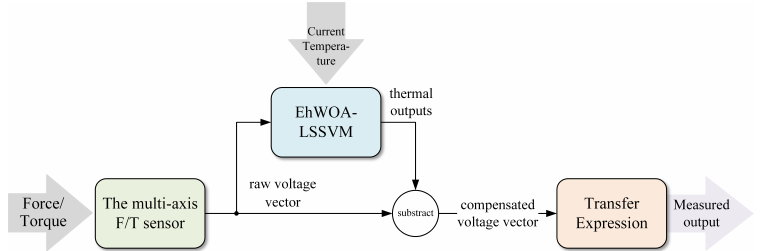
Figure 4. Compensating procedures of ensemble hWOA-LSSVM based on improved trimmed bagging.